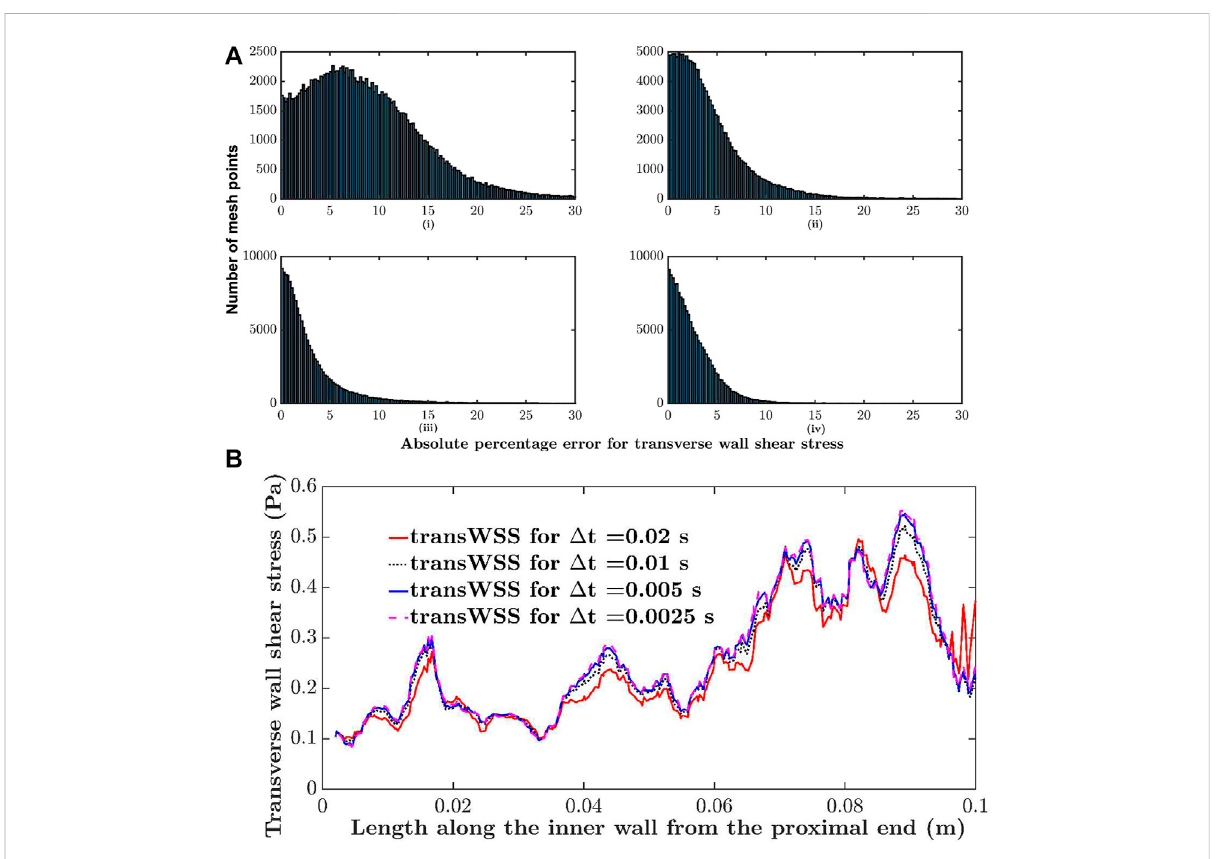
FIGURE 3 Sensitivity analysis. (A) Histogram comparing absolute percentage differences in transWSS at each mesh point between different mesh resolutions:i)90 kelementsvs.278 kelements,ii)278 kelementsvs.525 kelements,iii)525 kelementsvs.626 kelementsandiv)626 kelementsvs. 775 k elements. (B) Transverse wall shear stress along the inner wall of the RCA, computed with different time steps ( Δ